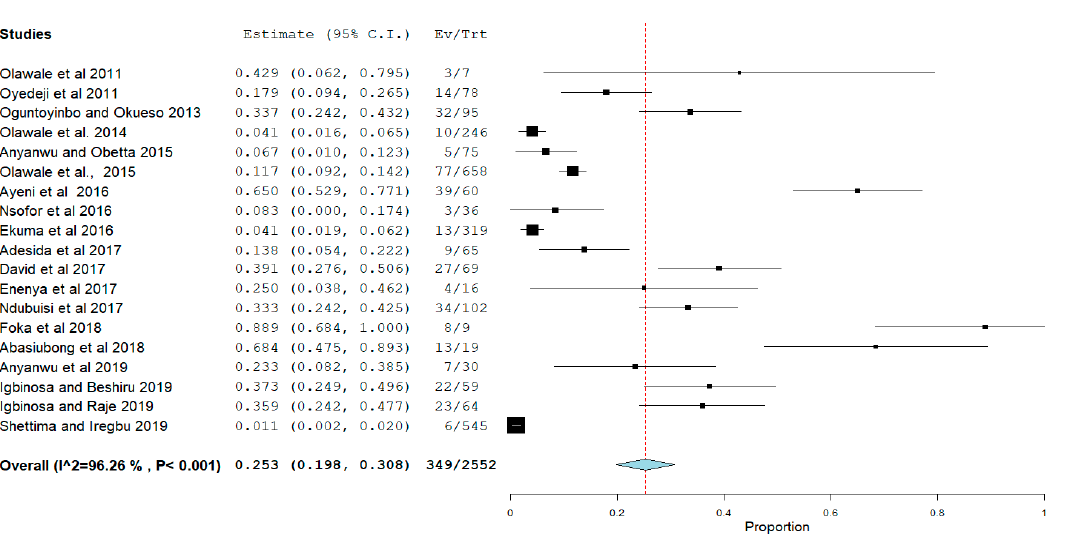
Figure 3. Forest plot showing the pooled prevalence of VRE in Nigeria.